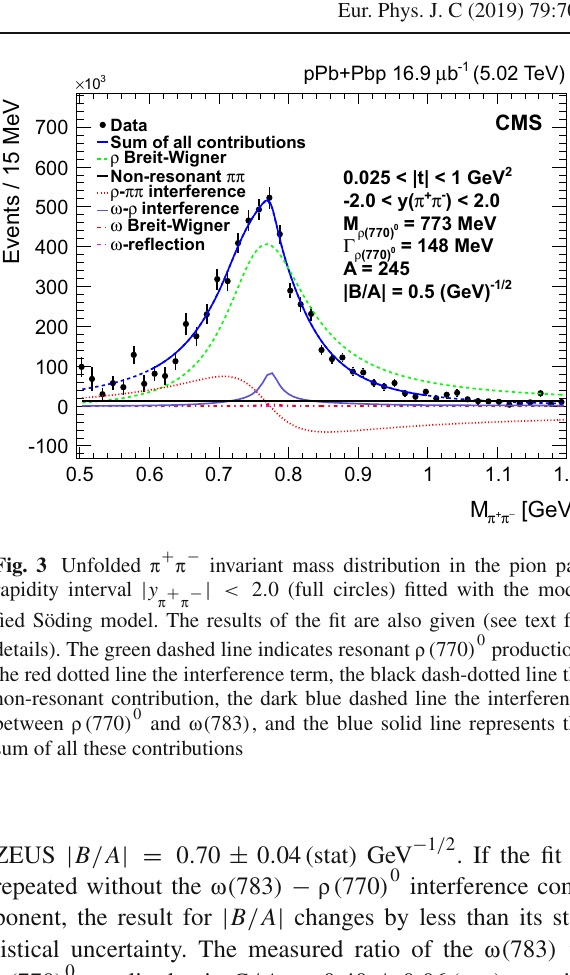
ZEUS | B / A | = 0 . 70 ± 0 . 04 (stat) GeV